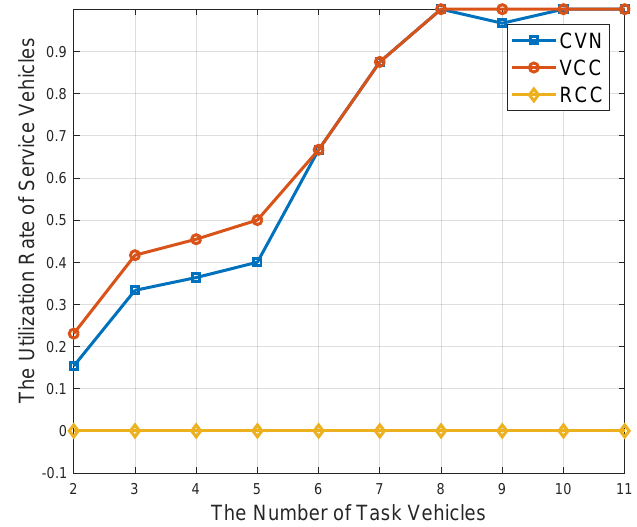
Figure 10. The resource utilization rate of service vehicles between CVN, VCC, and RCC